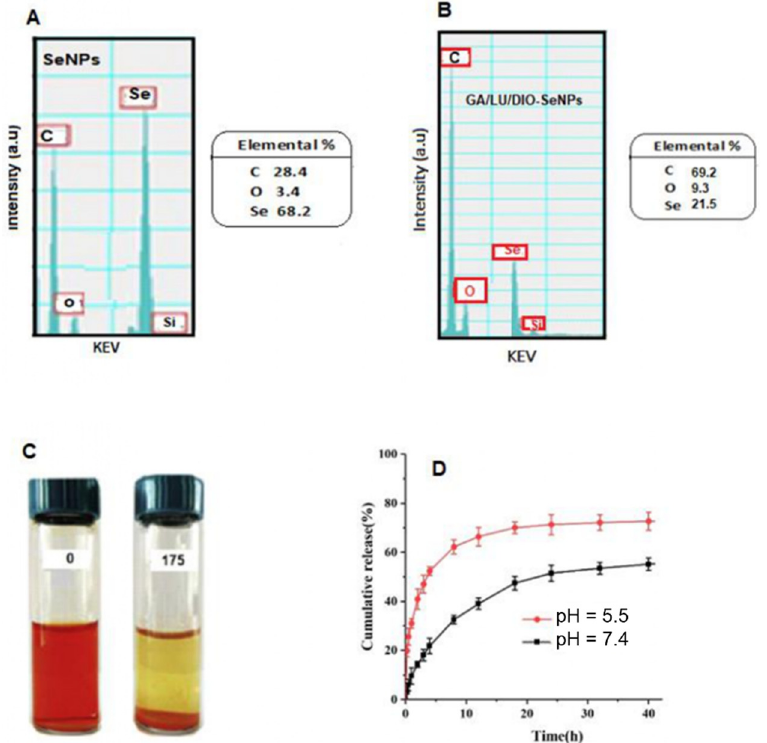
Figure Figure 4. The surface elemental compositions by energy-dispersive X-ray (EDX) of SeNPs ( A ) and GA/LU/DIO-SeNPs ( B ); photographs of GA/LU/DIO-SeNPs during a 175-day period ( C ); cumula- tive percentage (%) release profile of flavonoids in GA/LU/DIO-SeNPs at pH = 5.5 and pH = 7.4 until to 40 h at 37 °C ( D ).